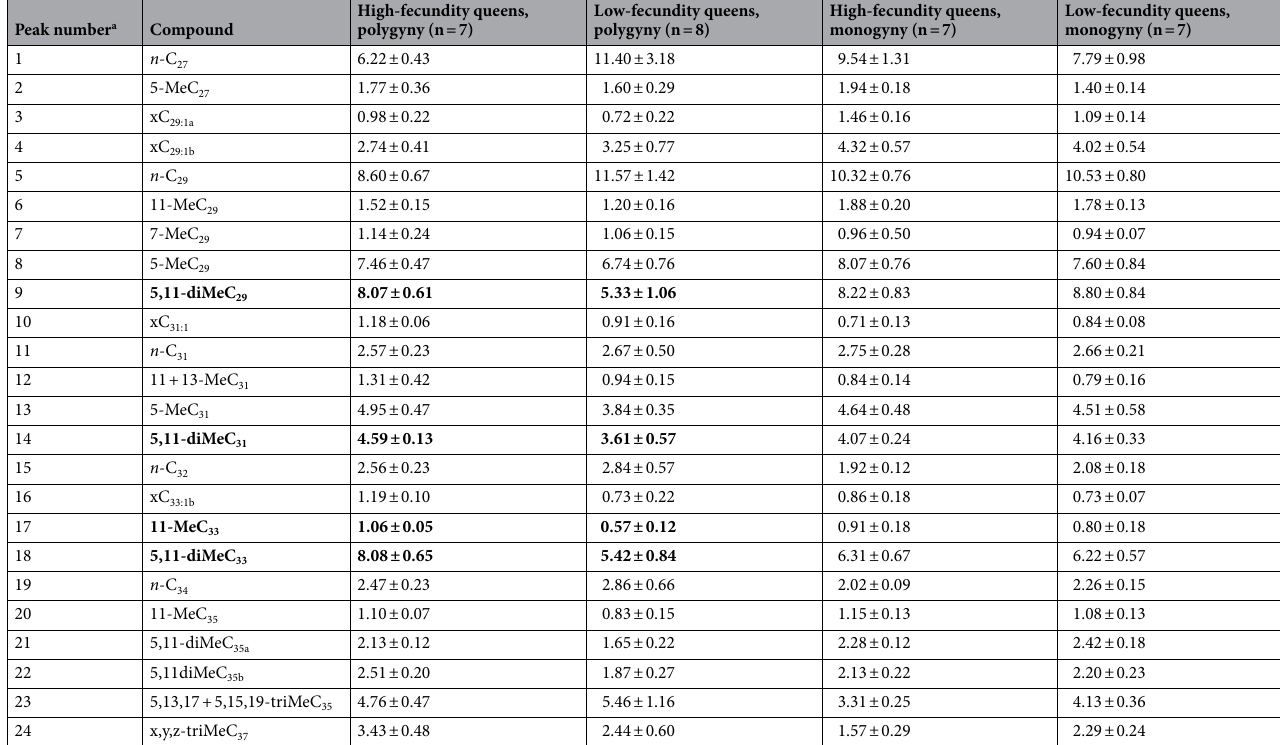
Table 2. Relative percentages (mean ± SE) of the major cuticular hydrocarbons of high- and low-fecundity queens under polygynous and monogynous conditions. Statistically significant results are in bold. a Compounds are ordered by retention time. See the peaks associated with the numbers in Fig.